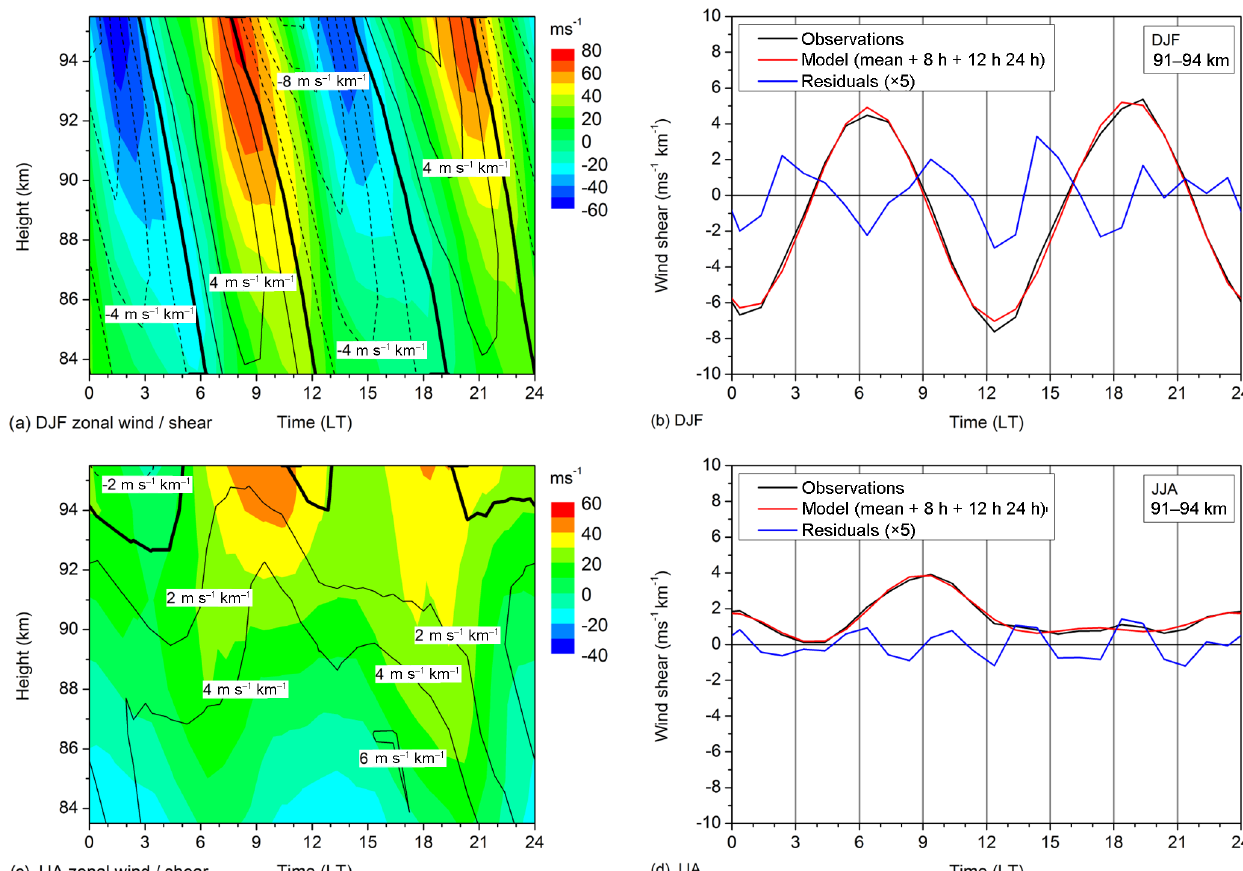
Figure 2. 2007–2016 mean DJF and JJA mean diurnal cycle of zonal wind and wind shear over Collm. Left panels: height–time cross sections of zonal wind (color coding) and wind shear (contour lines) for (a) DJF and (c) JJA. Dashed contour lines denote negative wind shear. Note the different color scaling for the DJF and JJA mean winds. Right panels: (b) DLF and (d) JJA wind shear at about 91 . 5km (black line), together with a fit including mean, 8, 12, and 24h components (red line). The residuals, multiplied by a factor of 5, are added as blue